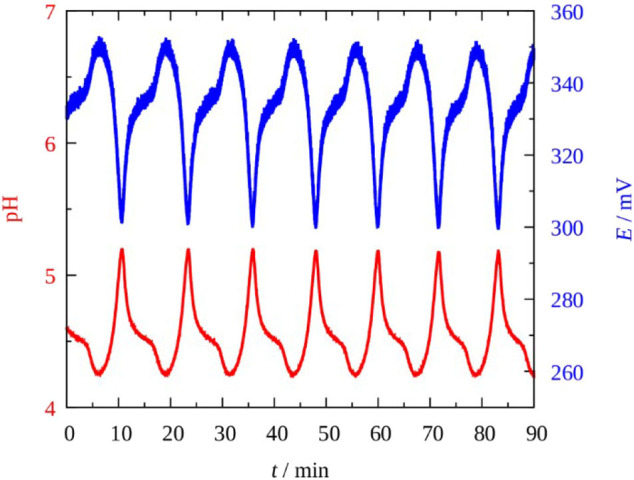
pH (red) and potential oscillations in the Pt vs. SCE electrode pair (blue) in the Cu2+-catalyzed sodium perborate–sodium thiosulfate CSTR system. [NaBO3]0 = 0.075 M; [H2SO4]0 = 0.0375 M; [Na2S2O3]0 = 5 × 10−3 M; [Cu2+]0 = 5 × 10−5 M; k0 = 2 × 10−3s−1; T = 25°C.